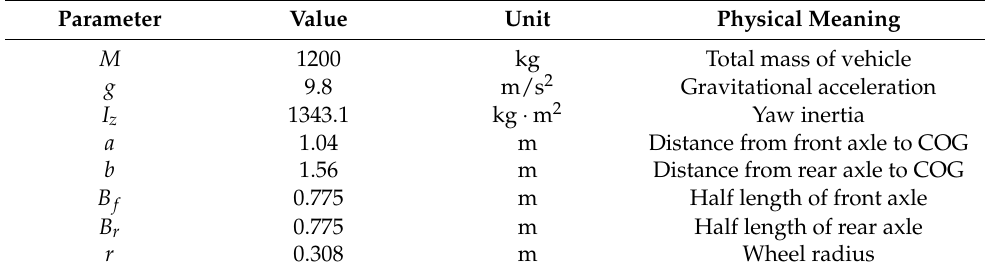
Table 2. Vehicle